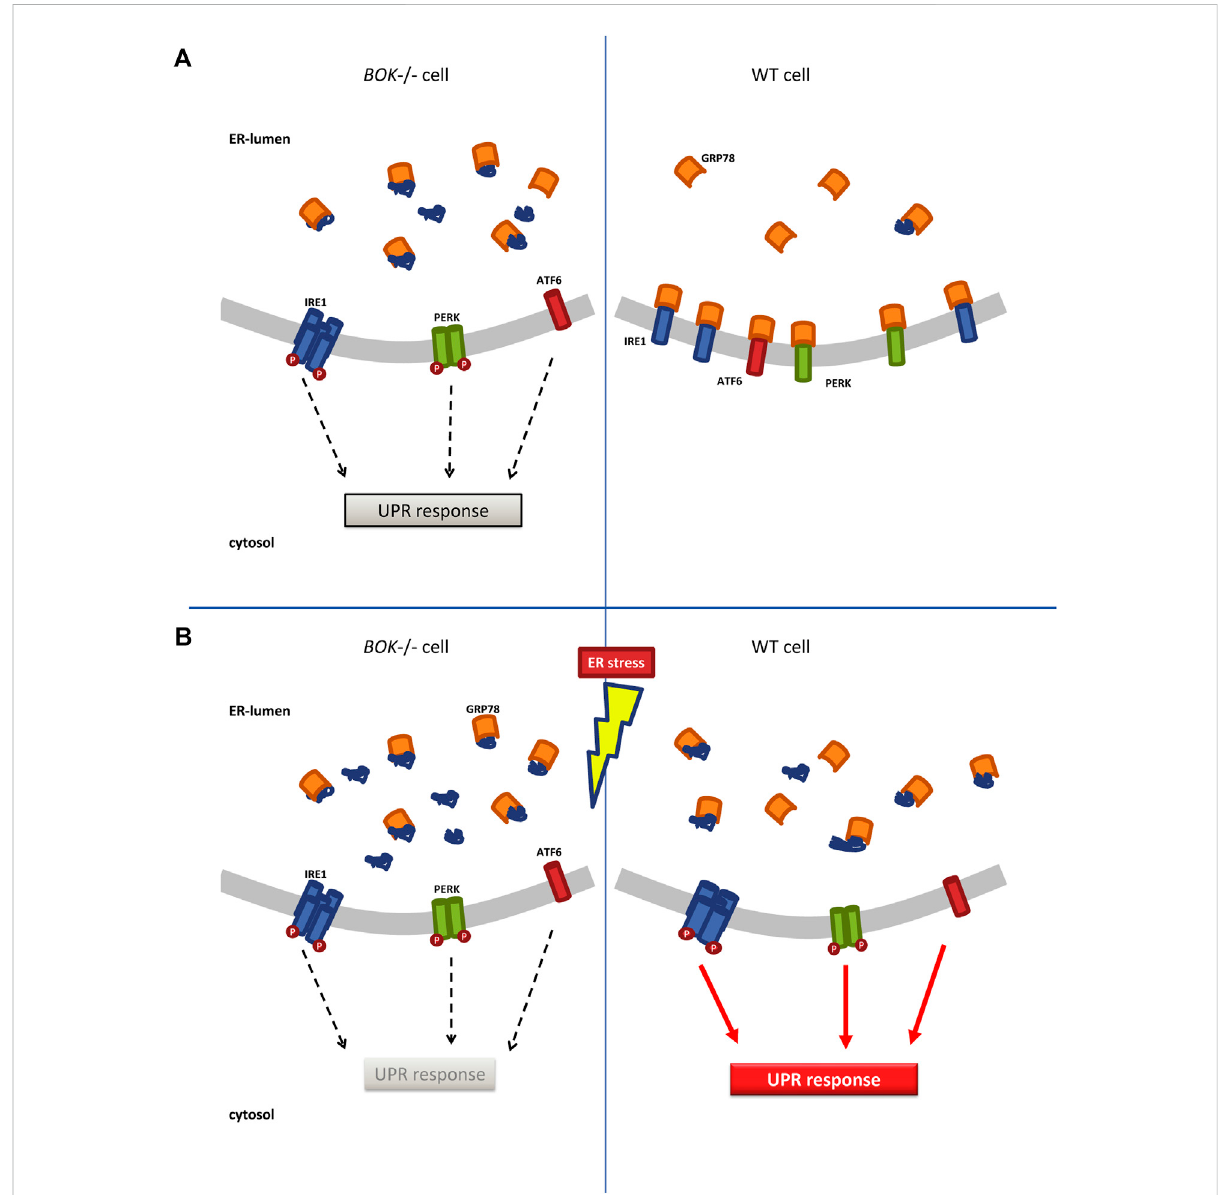
FIGURE 6 ER stress response in Bok − / − and WT cells. (A) Bok − / − cells experience chronic low levels of ER stress marked by lower motility of ER chaperone GRP78 indicating that GRP78 is bound to unfolded proteins. This allows for low-level oligomerization and activation of the membrane-signaling proteins IRE1, PERK, and ATF6, which initiate the UPR response. In contrast, in WT cells, free GRP78 is available in the ER and can bind to IRE1, PERK, and ATF6 keeping them inan inactive,monomeric state. (B) When Bok − / − cells are exposed to additional stress, theyfail to further increase their ER stress signaling and cannot mount a full UPR response. In WT cells, exposure to ER stress increases the amounts of unfolded proteins in the ER, which leads to dissociation of GRP78 from IRE1, PERK, and ATF6 fully activating the